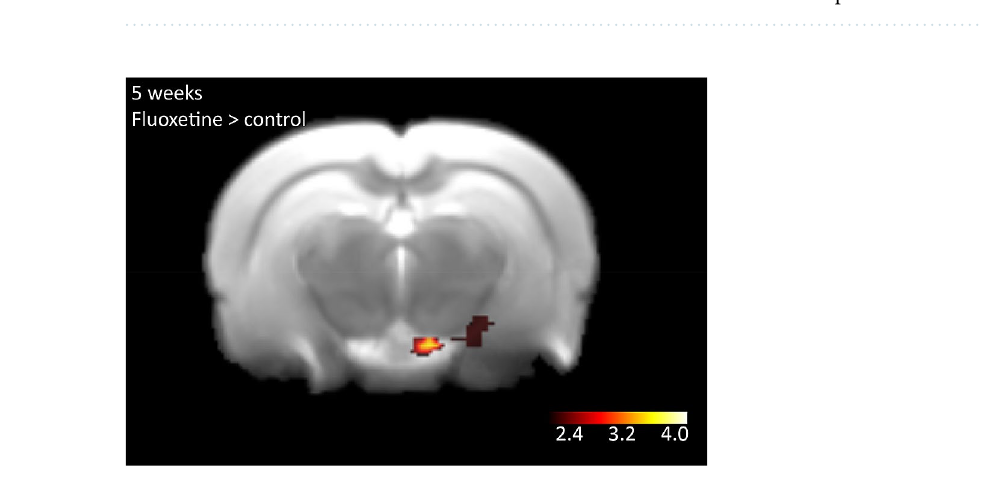
Table 1. Peak Maxima of overall contrast whiskers vs no whiskers stimulation p < 0.001.